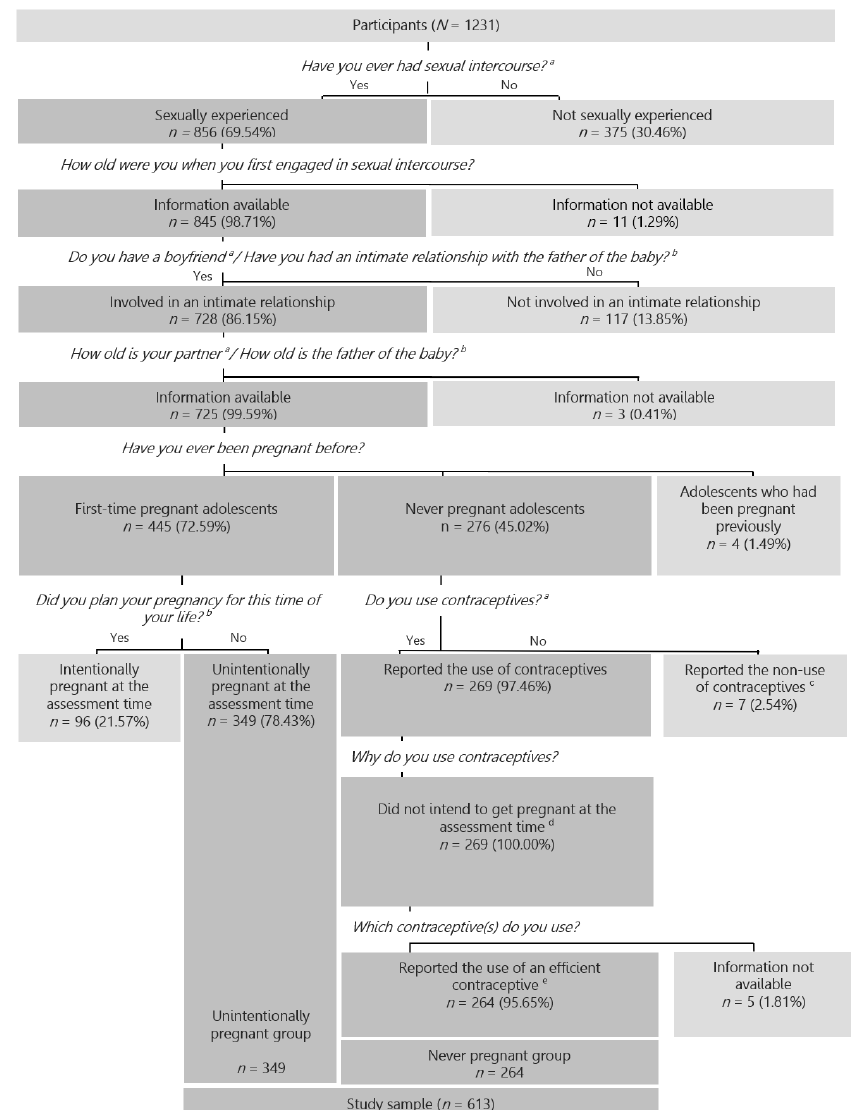
Figure 2. Sample selection. Note. The order of the questions in the figure follows the order by which